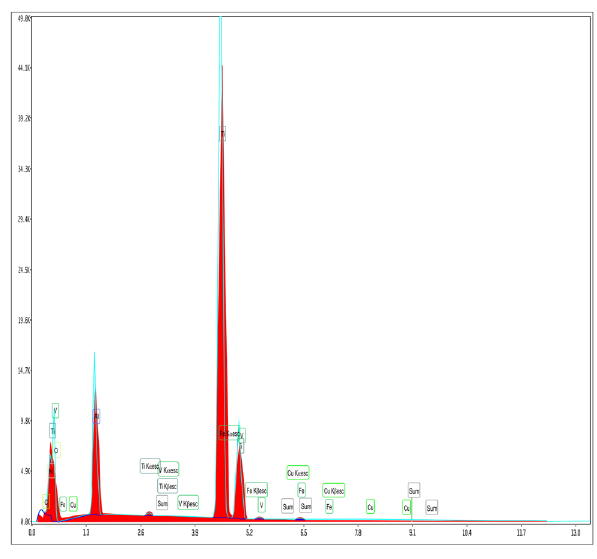
Figure 14: EDS of sample the alloying elements and traces of carbon, iron, and Figure 14 corresponding to EDS for sample S6 shows also the highest peak for titanium, followed by oxygen and high values for aluminum and vanadium; one may also notice the presence, besides carbon and iron of